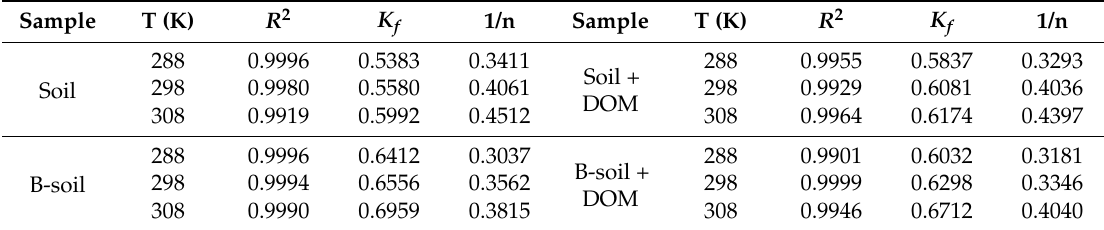
Figure 6. Adsorption isotherms of soil ( a ), B-soil ( b ), soil+DOM ( c ), and B-soil+DOM ( d ). Table 2. Fitting results of the Freundlich model.